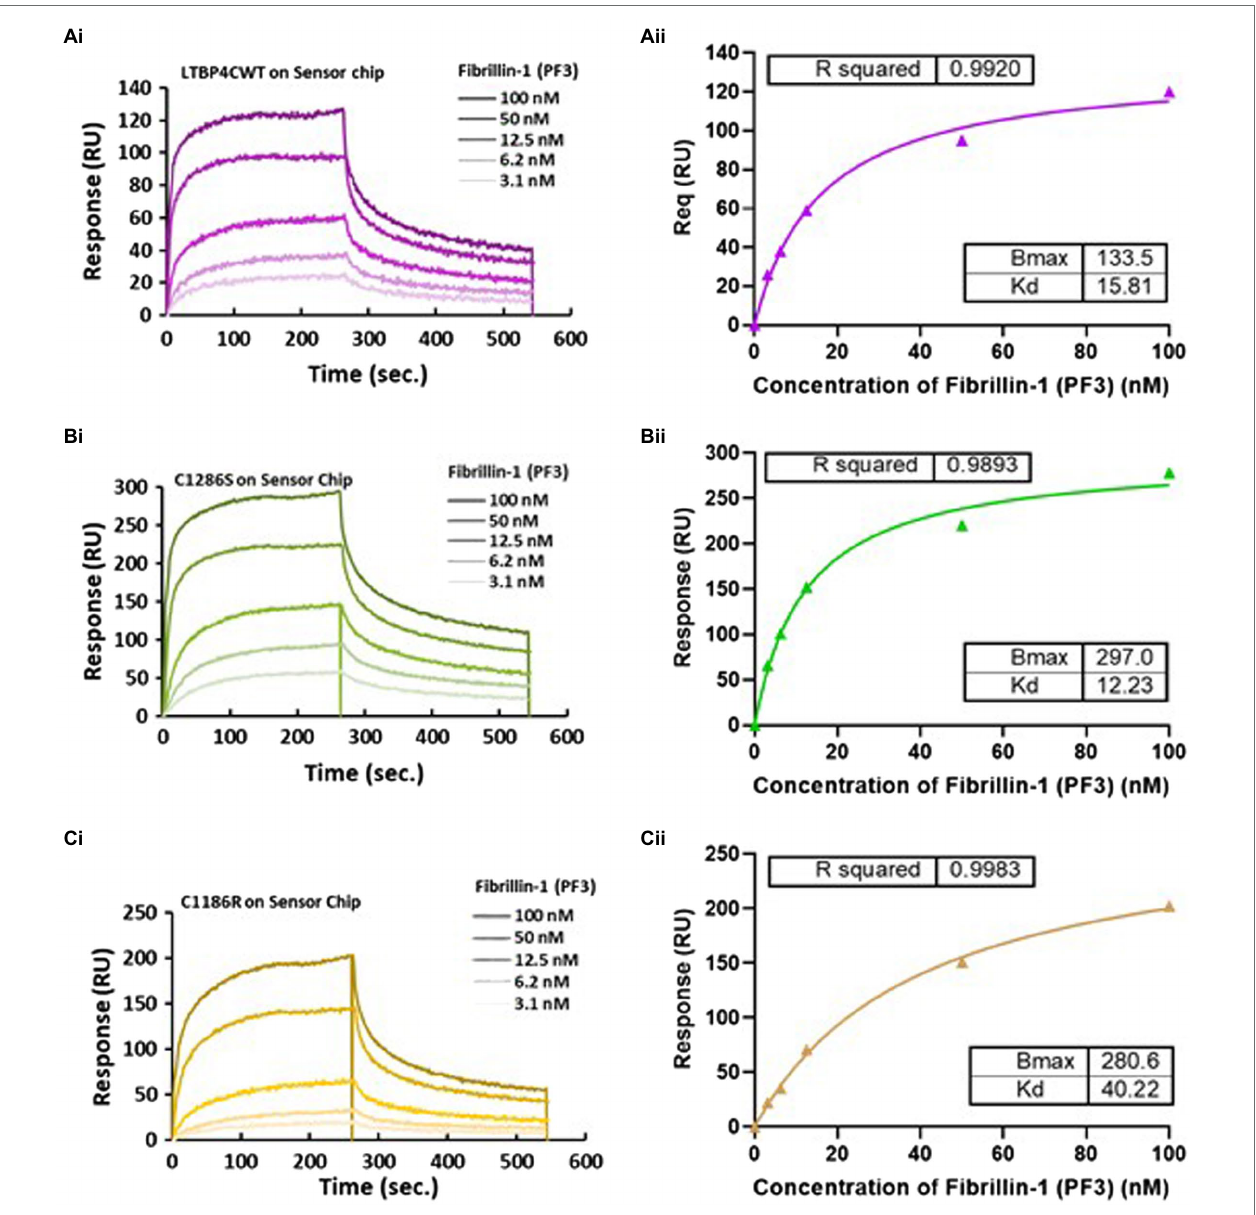
FIGURE 4 | Surface plasmon resonance analysis of the fibrillin-1 PF3 construct binding to LTBP4. (A) CWT, (B) C1286S, and (C) C1186R. LTBP4 was immobilised on the sensor chip (GLC) using amine coupling and purified fibrillin-1 (PF3) was injected as analyte at different concentrations (100–3.1 nm) over the immobilised LTBP4. The binding affinity was determined by steady state with equilibrium response plotted against fibrillin-1 concentration as shown in panel (ii) for all constructs. All experiments were performed in at least duplicate and representative curves